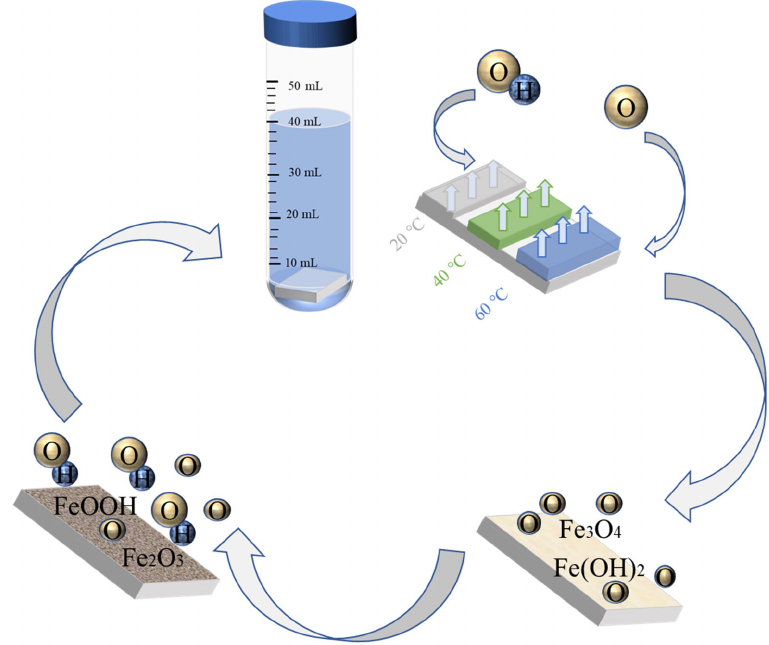
Figure 10. Schematic diagram of the passivation mechanism of Q235 steel.